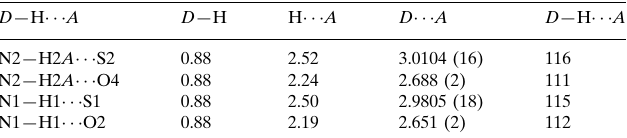
Hydrogen-bond geometry (A˚ , (cid:1) ). D —H (cid:2)(cid:2)(cid:2)